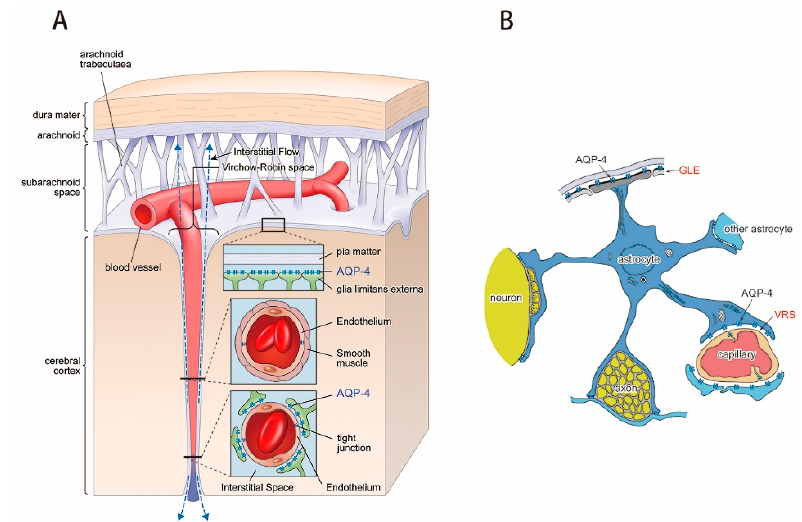
Figure 7. Astrocyte and polarized localization of AQP ‐ 4. ( A ): Expression of AQP ‐ 4 in the brain is highly polarized to endfeet of astrocytes at two specific locations, the glia limitans externa (GLE) at the cortical surface and peri ‐ capillary Virchow ‐ Robin space (VRS). VRS constitutes fluid ‐ filled canals surrounding perforating arteries, capillaries, and veins in brain parenchyma. While pia mater ends near the brain surface, VRS continues into the brain parenchyma accompanying a perforating artery; ( B ): Astrocyte endfeet attach to many structures. However, AQP ‐ 4 is found only at the GLE and VRS. AQP ‐ 4 at peri ‐ capillary VRS connects astrocyte intracellular space and extracellular (interstitial) space. Water efflux from astrocytes into the interstitial space must be balanced by an equivalent amount of water influx in order to maintain water equilibrium. Since astrocyte AQP ‐ 4 is also localized